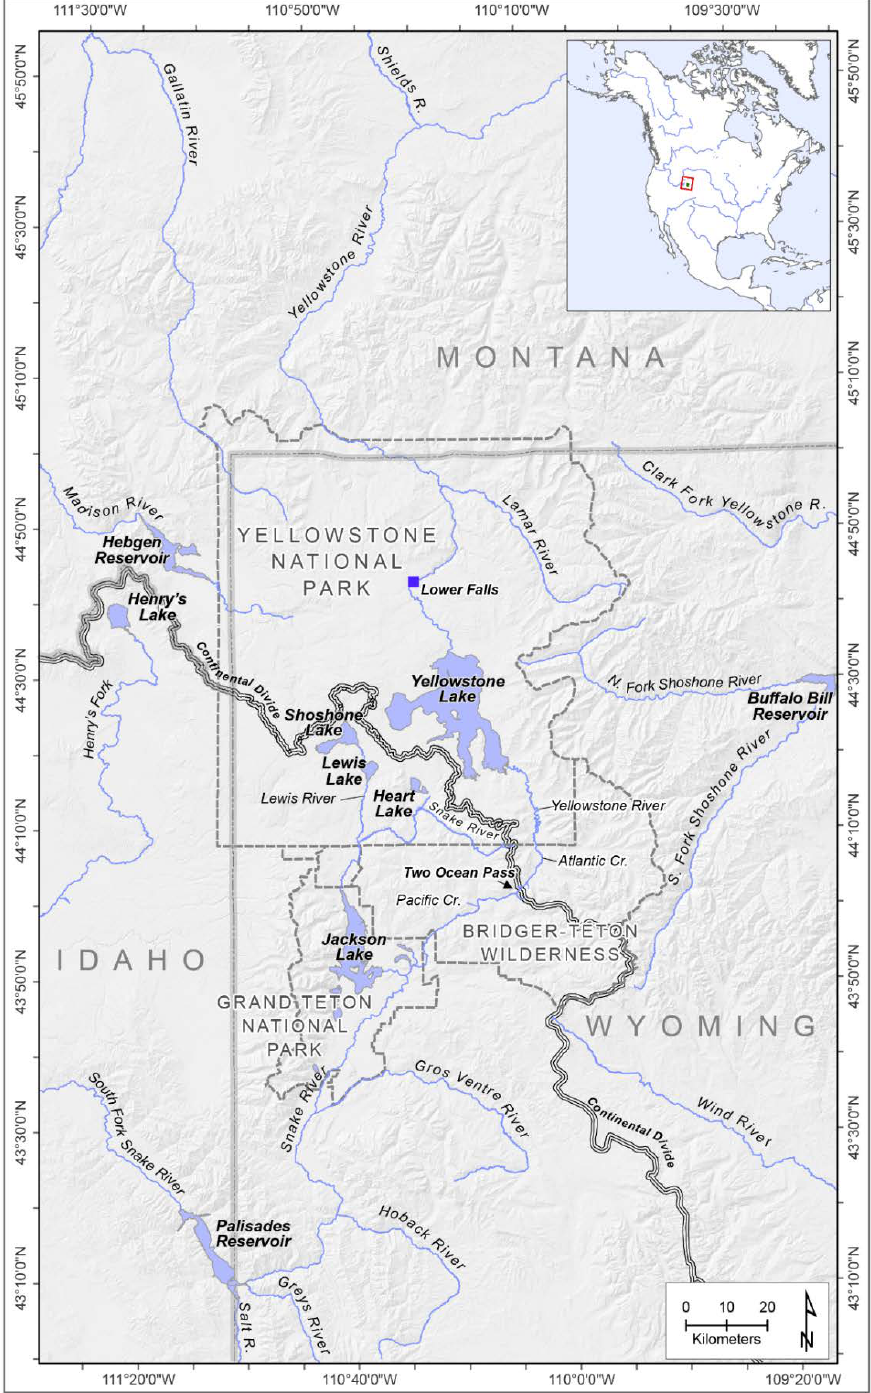
Figure 1. Headwaters of the Atlantic and Pacific drainages in Idaho, Montana, and Wyoming, including the upper Snake and Yellowstone rivers in Yellowstone National Park, Grand Teton National Park, and the Bridger-Teton Wilderness where surface waters of both systems naturally join on the Continental Divide at Two Ocean Pass.